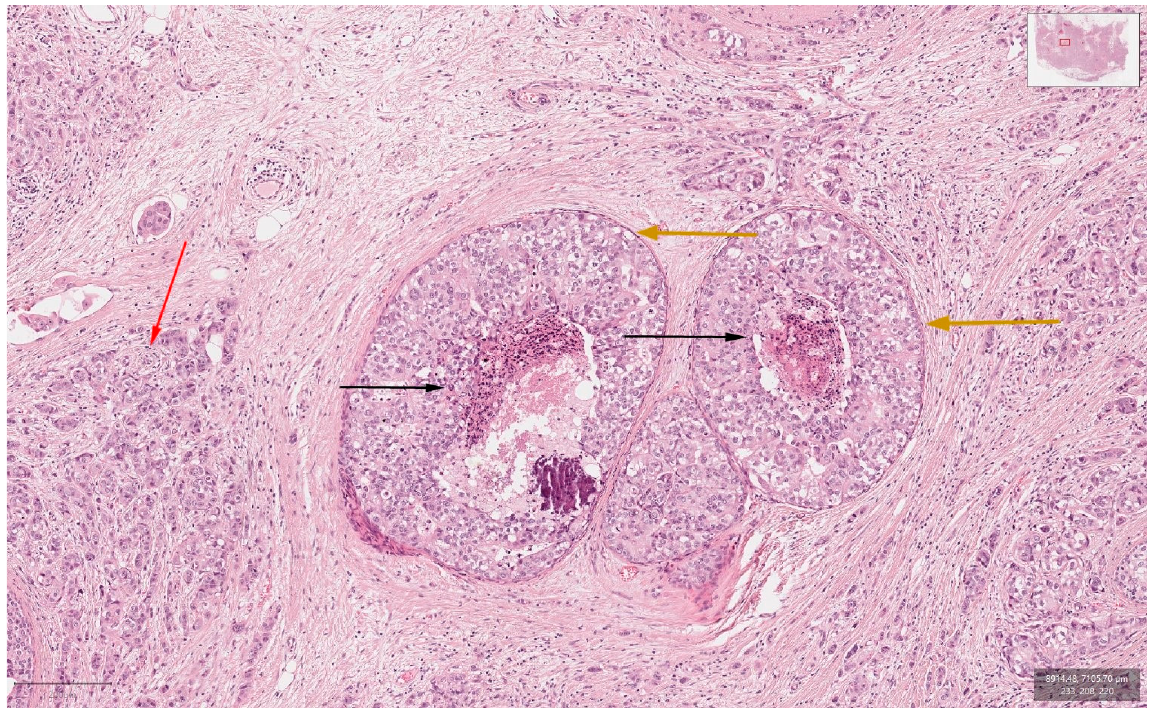
Figure 2. Hematoxylin-and-Eosin staining (200× magnification) showing the invasive carcinoma component (marked red arrow), ductal carcinoma in situ component (marked orange arrows) and comedonecrosis (marked black arrows).